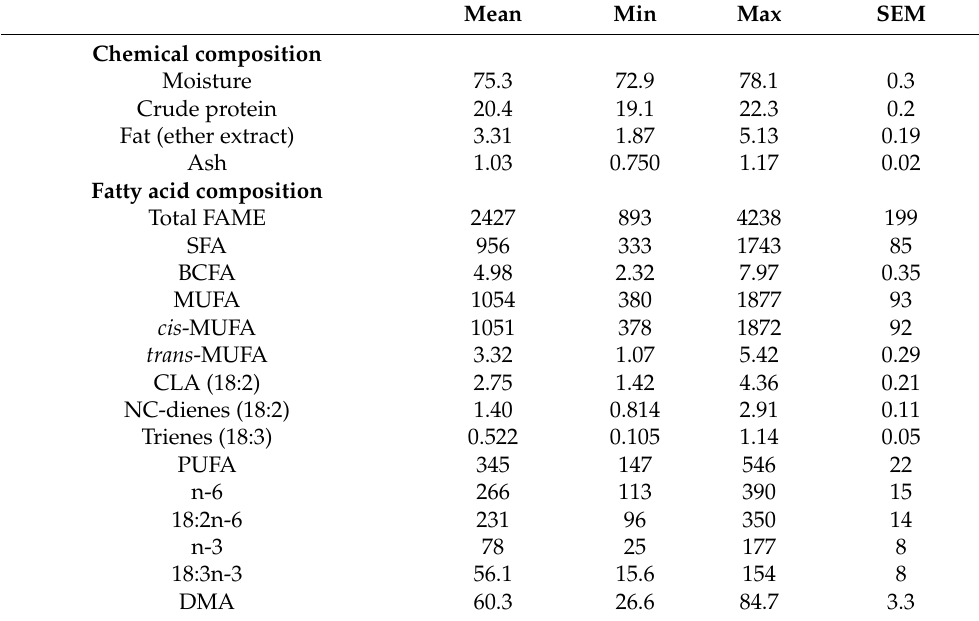
Table 1. Chemical (%) and fatty acid (absolute basis: mg/100 g of meat) composition of horse longissimus thoracis and lumborum muscle ( n = 20).